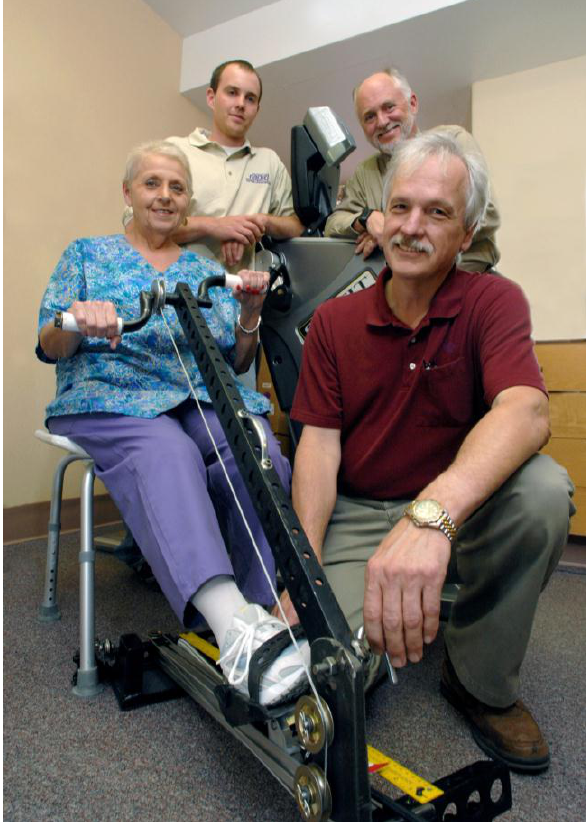
Figure 4. Student and orthopedic surgeon create rehabilitation device for patients recovering from total knee